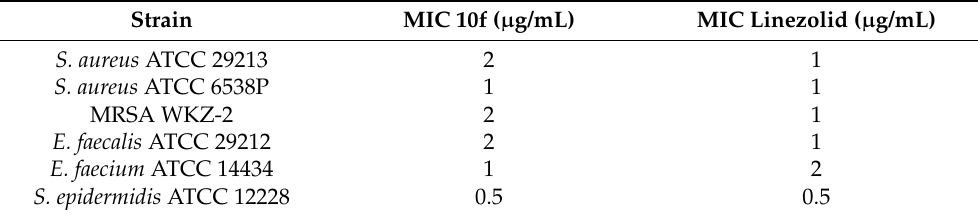
Table 2. 10f and linezolid MIC values calculated against different